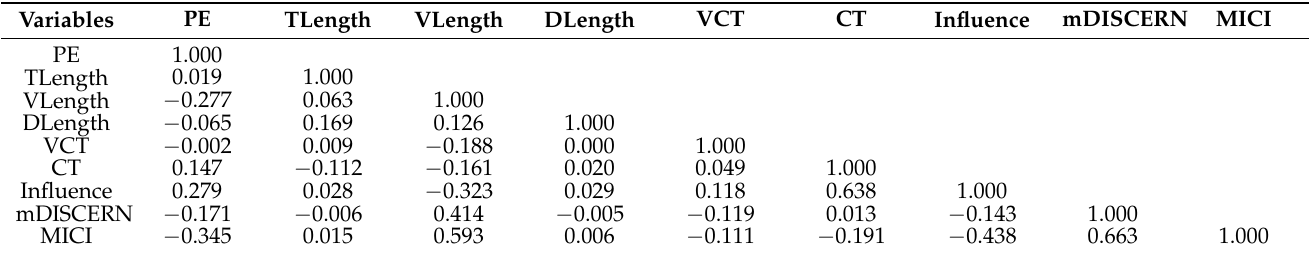
Table 8. Pairwise correlations.